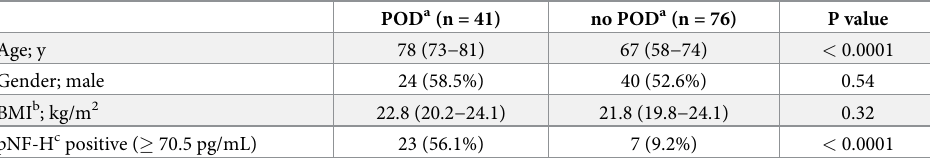
Table 1. Characteristics of patients grouped according to development of postoperative delirium.